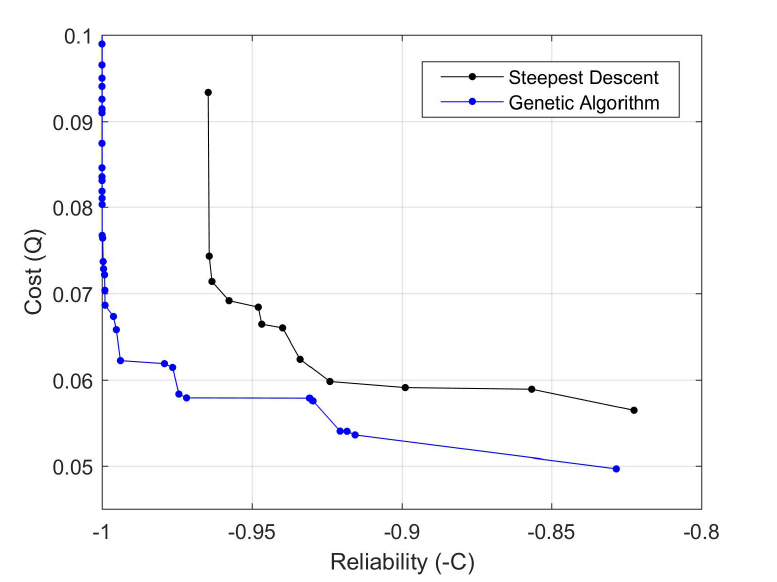
Figure 11. Comparison of the obtained Pareto